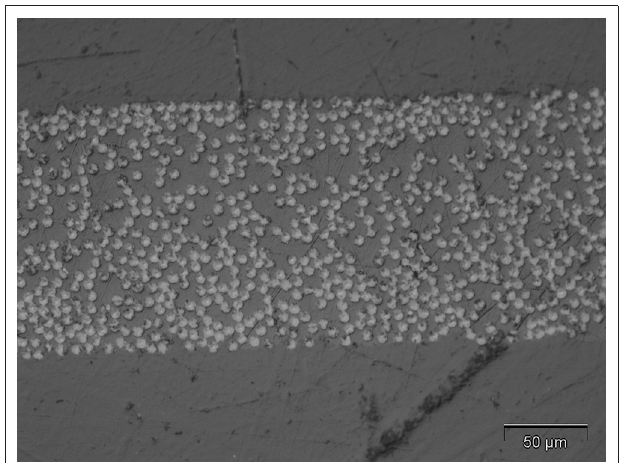
FIGURE 1 | Microscopic image of the prepreg ply.